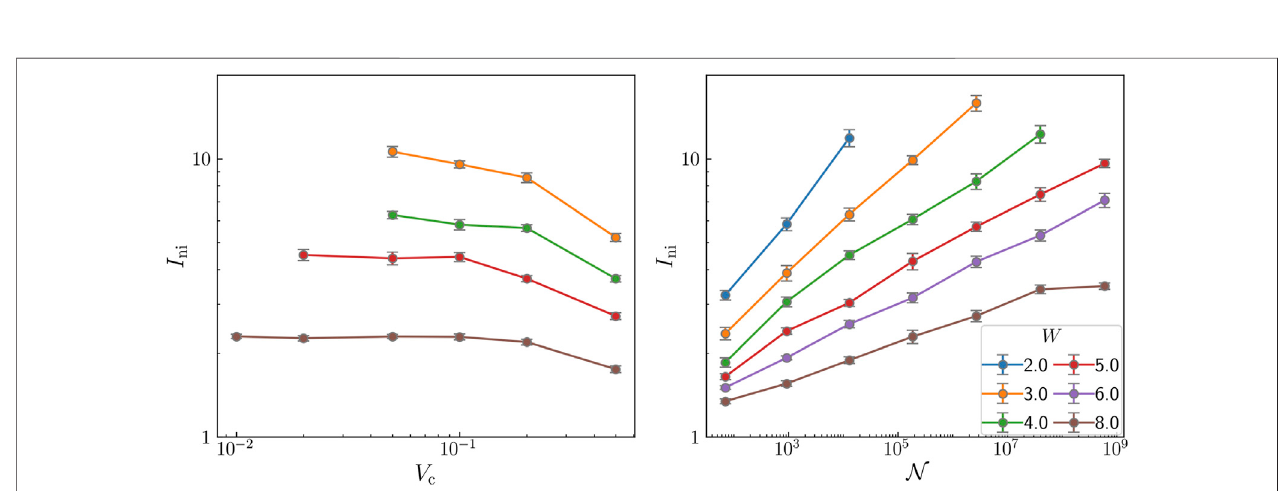
FIGURE5|(A) Median oftheIPRasafunctionofthecutoff inthepotentials considered forseveralvaluesofthedisorderand systemsize L (cid:1) 20. (B) Median ofthe IPR versus the size of the Hilbert space on a double logarithmic scale for several values of the disorder and L (cid:1) 20.